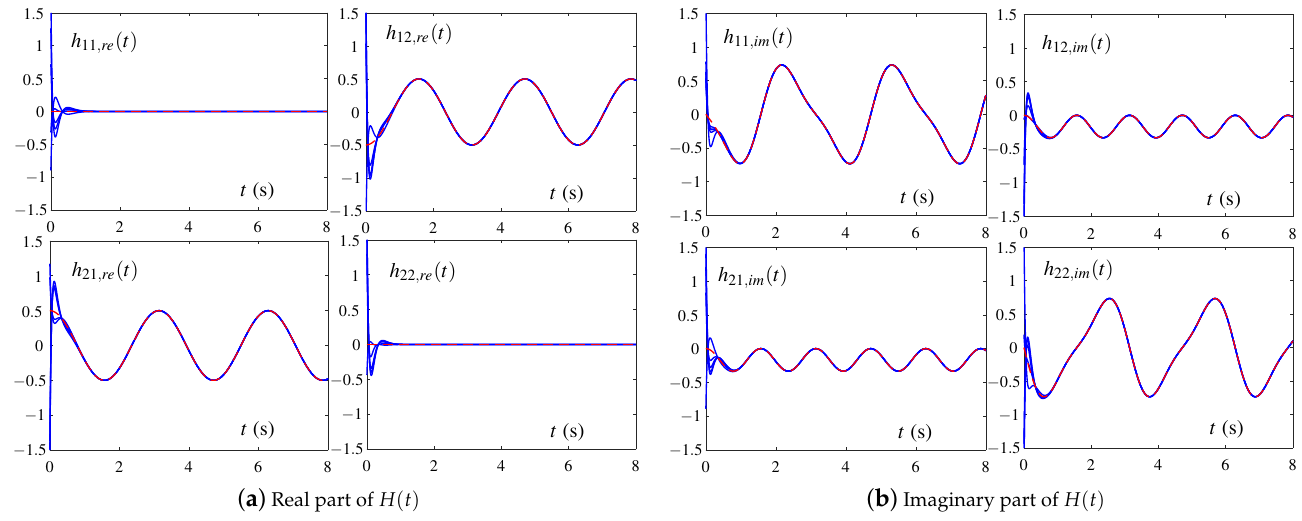
Figure 1. CNRZNN model (7) solves CTDLE (14) starting from five initial complex matrices [ ( 2 + 2 i ) ,2 + 2 i ] 2 × 2 , where the solid blue line represents the state trajectory of H ( t ) and the red − dotted line stand for H ∗ ( t ) . ( a ) Real part of the state matrix H ( t ) . ( b ) Imaginary part of the state matrix H ( t )